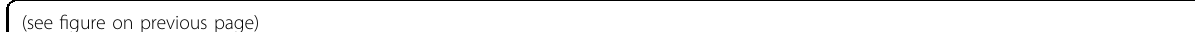
(see fi gure on previous page) Fig. 3 MID-00935 improves insulin signaling by increasing IRS-1 levels. HA-MG53 and Flag-IRS-1 were transiently transfected in HEK 293 cells for 24 h, and cells were treated with the indicated concentrations of MID-00935 or MG132 (2.5 μ M) for 12 h. Flag-IRS-1 and HA-MG53 levels were determined by immunoblotting ( a ). Four-day differentiated C2C12 myotubes were treated with the indicated concentrations of MID-00935 or vehicle (0.1% DMSO) for 24 h. IRS-1 and MG53 protein levels were determined by immunoblotting ( b ). The mRNA level of IRS-1 was determined by qPCR. ( n = 3) ( c ). Four-day differentiated C2C12 myotubes were pre-incubated with 0.1% DMSO or 5 μ M MID-00935 for 24 h and then treated with cycloheximide (CHX) for 0, 4, or 8 h. The protein levels of IRS-1 and MG53 were determined by immunoblotting ( d ). Four-day differentiated C2C12 myotubes were treated with MID-00935 (5 μ M) for 24 h and stimulated with 20 nM insulin for 0, 5, and 10 min. The protein levels of MG53, IRS-1, p- IRS-1(Y608, Y628, S302, S612), Akt, p-Akt, Erk1/2, p-Erk1/2, and GAPDH were determined by immunoblotting ( e ). Four-day differentiated C2C12 myotubes were incubated with vehicle (0.1% DMSO) or 5 μ M MID-00935 for 24 h, stimulated with 20 nM insulin for 20 min and then incubated with 2-DG (10 mM) for 20 min. Glucose uptake is presented as cell-associated fl uorescence ( f ), and insulin-induced glucose uptake is presented as a